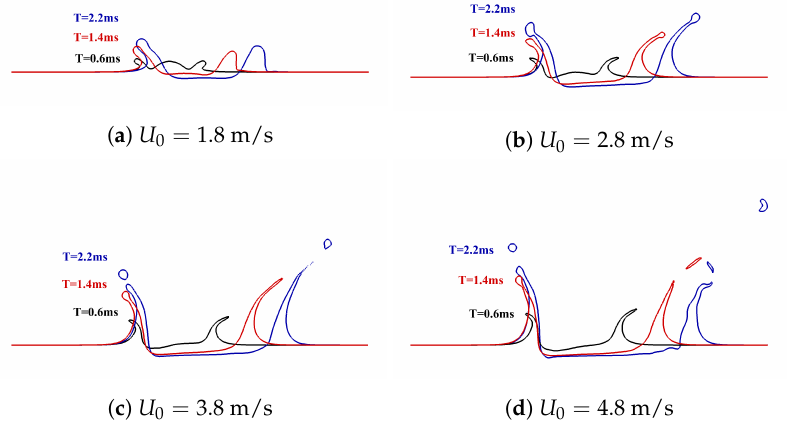
Figure 18. Interface of a drop impact upon a dynamic film at different impact velocities when θ = 30 ◦